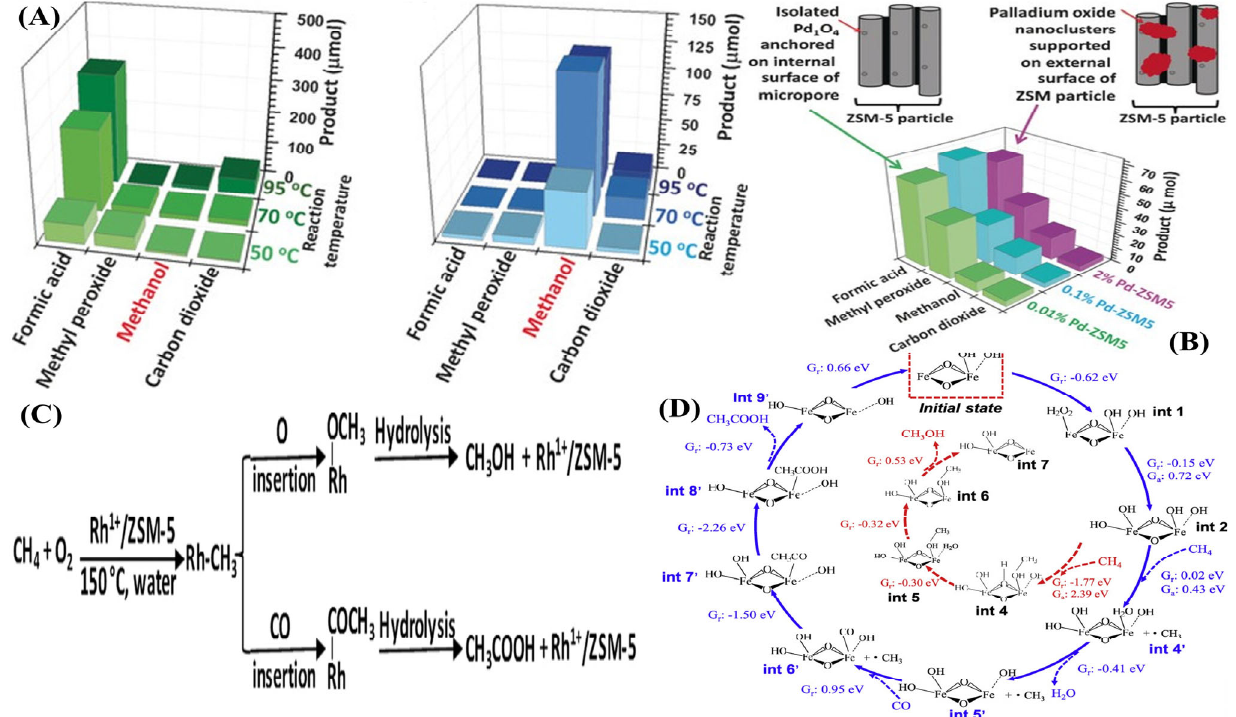
Figure 6. ( A ) Yields of products of transformation of CH 4 catalyzed by 0.01, 0.10, and 2.0 wt% Pd/ZSM ‐ 5 for methane partial oxidation at 50 °C; ( B ) catalytic performance of 0.01 wt% Pd/ZSM ‐ 5 at 50, 70, and 95 °C, and 0.01 wt% Pd/ZSM ‐ 5 loaded with 2 wt% CuO at 50, 70, and 95 °C, the plotted yields of products formed over 28 mg 0.01 wt% Pd/ZSM ‐ 5, or 0.01 wt% Pd/ZSM ‐ 5 loaded with 2.0 wt% CuO were the values after subtraction of the yields of the products formed over 28 mg of ZSM ‐ 5 (without the Pd sites) under the same catalytic conditions. Reprinted/adapted with permission from Ref. [115]. Copyright 2016, copyright Willy ‐ VCH GmbH, ( C ) the conversion to methanol and acetic acid followed independent reaction pathways. Reprinted/adapted with permission from Ref. [14]. Copyright 2017, copyright Springer Nature Ltd., and ( D ) proposed reaction networks for the CH 3 OH/CH 3 COOH formation, the calculated Gibbs reaction energy, as well as the free energy barriers. Reprinted/adapted with permission from Ref. [116]. Copyright 2022, copyright Elsevier